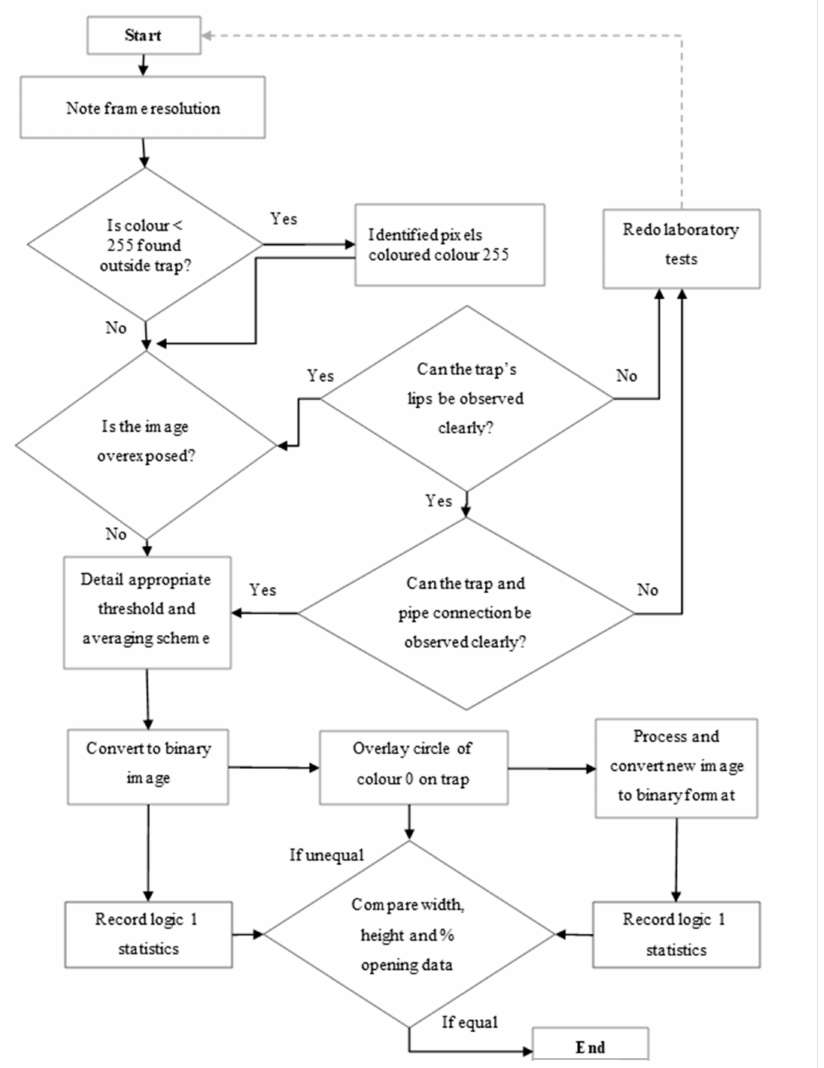
Figure 10. Procedure to establish the size of the waterless trap seal orifice in